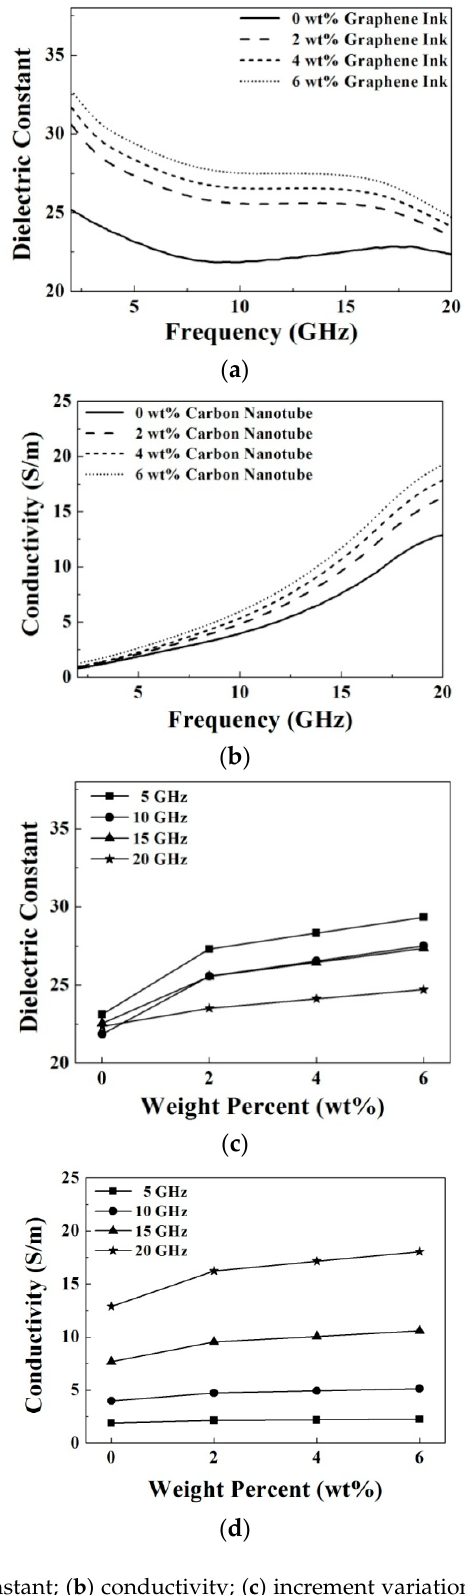
Figure 8. ( a ) Dielectric constant; ( b ) conductivity; ( c ) increment variation of the dielectric constant, and ( d ) increment variation of the conductivity of the prepared samples as functions of the doping concentrations of graphene ink.